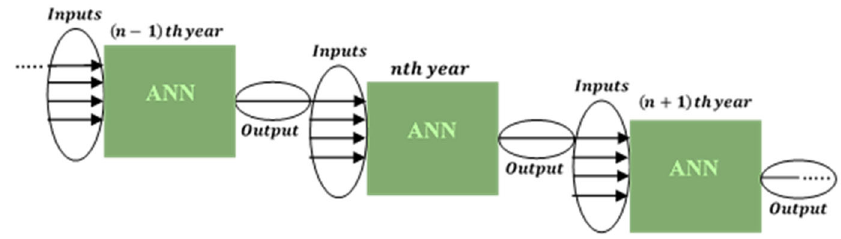
Figure 12. Schematic flow chart of the prediction in sequential years.